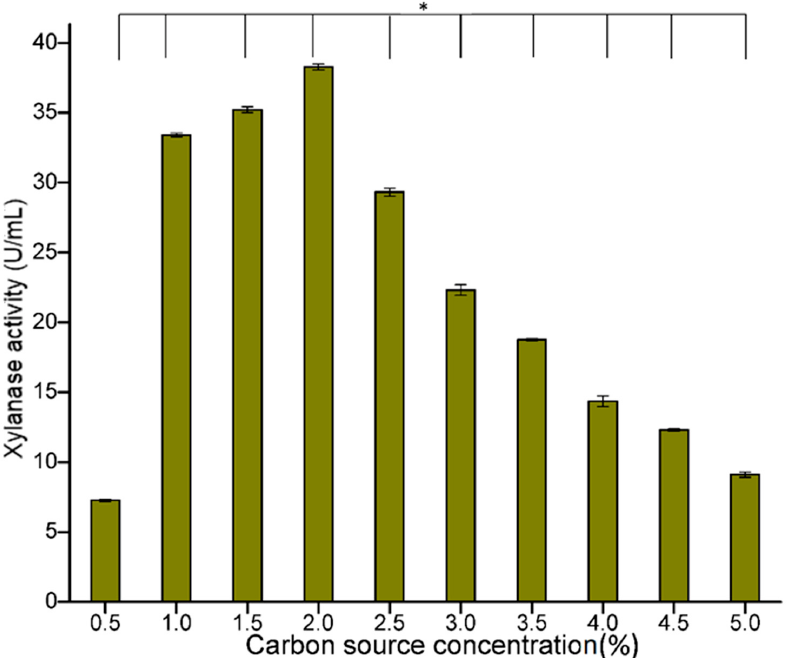
Figure 4. Effect of carbon source concentration on xylanase production by B. safensis XPS7 (Medium: M5; temp.: 30 °C; time: 24 h; pH: 8; inoculum: 4%). All the experiments were performed in triplicate. M5; temp.: 30 ◦ C; time: 24 h; pH: 8; inoculum: 4%). All the experiments were performed in